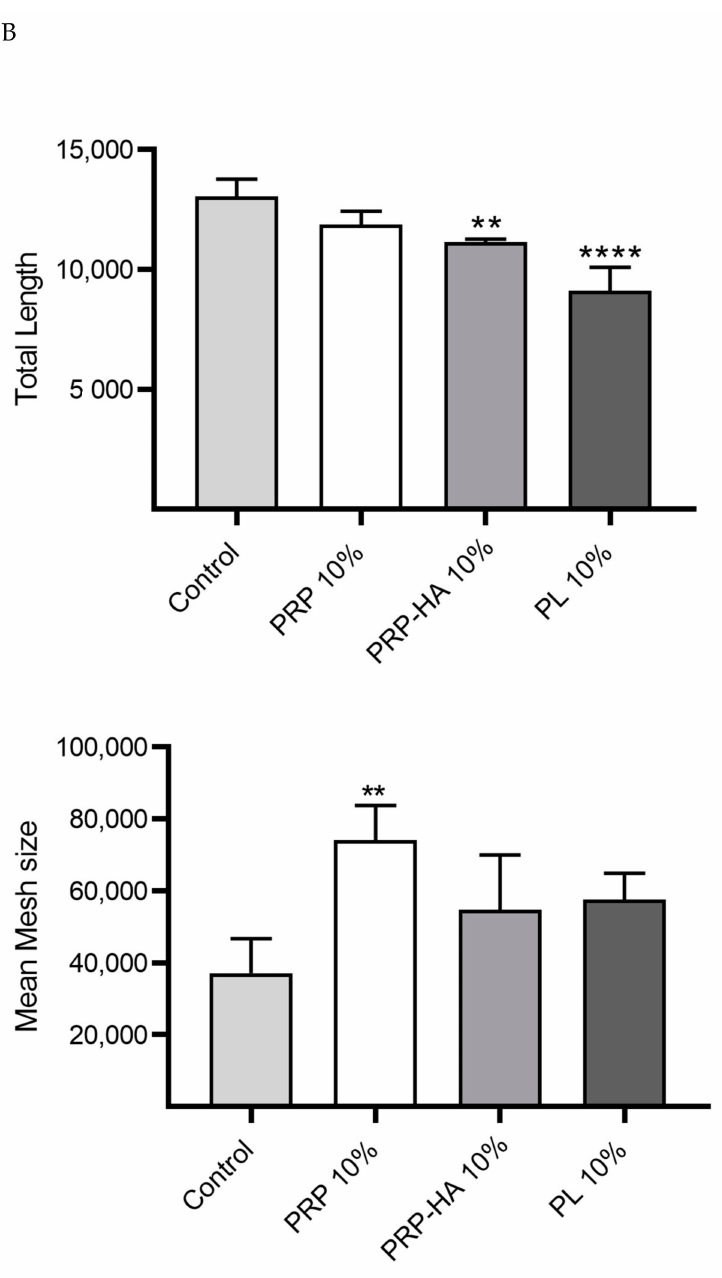
Figure 2. Platelet-derived products have different effects on HUVEC tube formation on Matrigel ( A ). Representative images of the tube formation experiment after 6 h of incubation with control medium (heparin), or platelet-derived products. Scale bars = 300 µ m. Arrows indicate platelets attached to the endothelial lining of the pseudo-vascular structure ( B ). Graph shows the average area without cells relative to the total area., ** p -value < 0.01, **** p value < 0.0001 compared to control